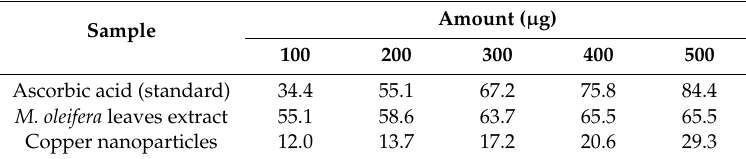
Table 3. Antioxidant activity percentage (AA%) using DPPH assay.